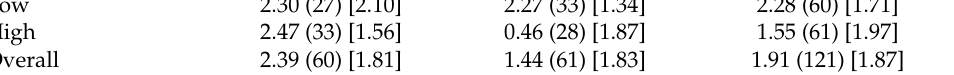
Panel B: ANOVA Tests of between-Subjects